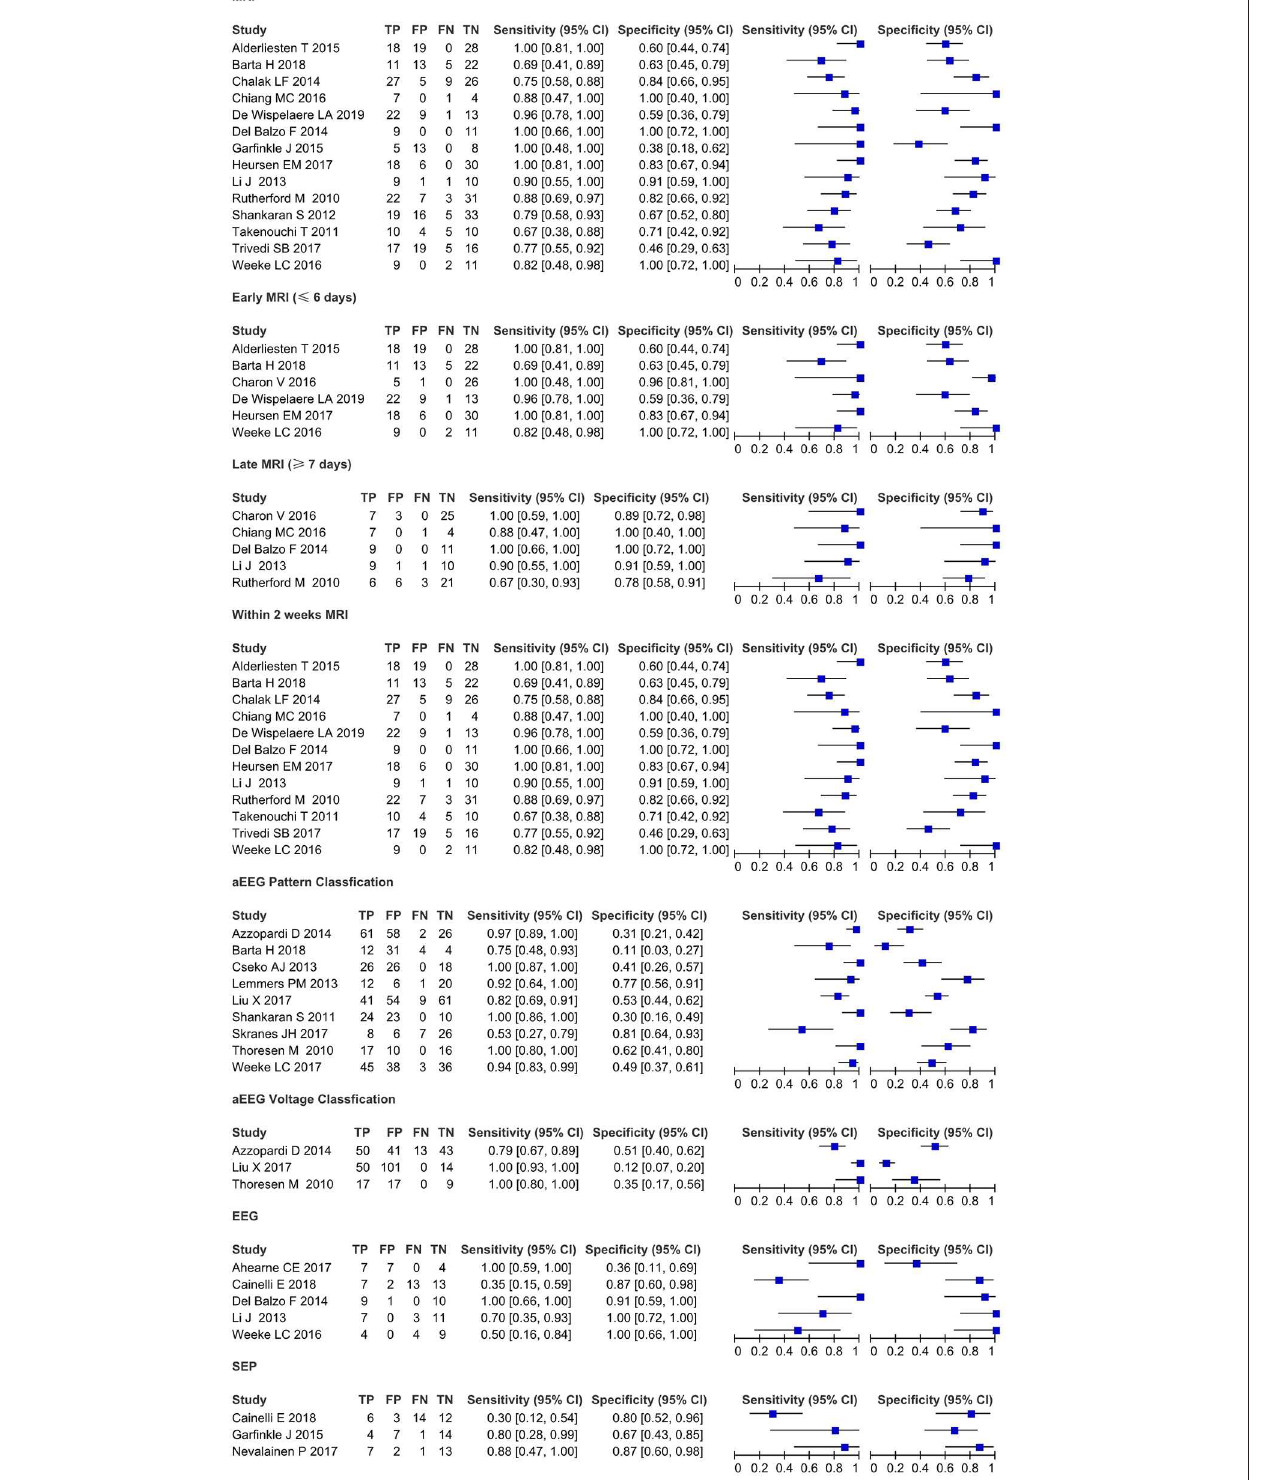
Frontiers in Neurology |